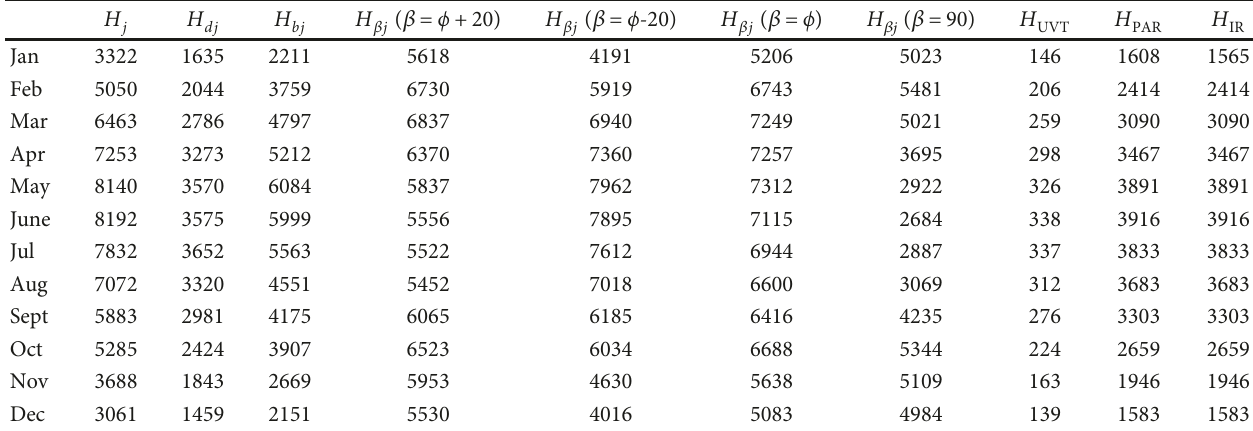
Table 10: Representative year monthly maximum values.